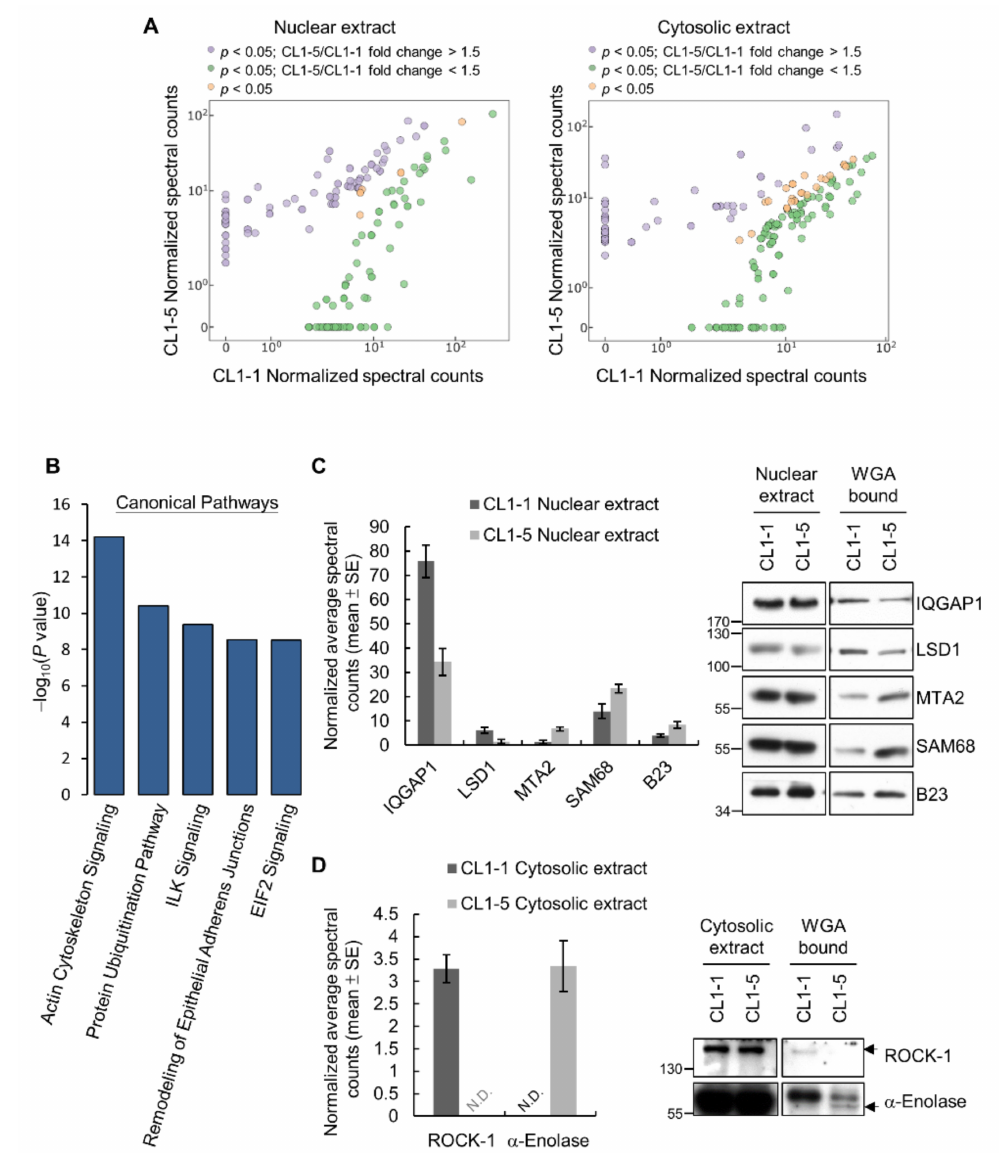
Figure 2. Differential WGA-bound glycoproteins identified in CL1-1 and CL1-5 cells. ( A ) Scatter plots of the normalized spectral counts of proteins with statistically significant (Student’s t -test, p -value < 0.05) fold changes in their amounts in WGA-enriched nuclear or cytosolic fractions from CL1 and CL1-5 cells. ( B ) Top canonical pathways identified by IPA of differential WGA-bound glycoproteins. ( C – D ) Validation of representative differential WGA-bound nuclear ( C ) and cytosolic ( D ) glycoproteins by Western analysis. Shown on the left are bar graphs of average normalized spectral counts listed in Tables S1 ( C ) and S2 ( D ); N.D., not determined. Representative Western results are shown on the right. Detailed information about the Western blotting can be found in Figure